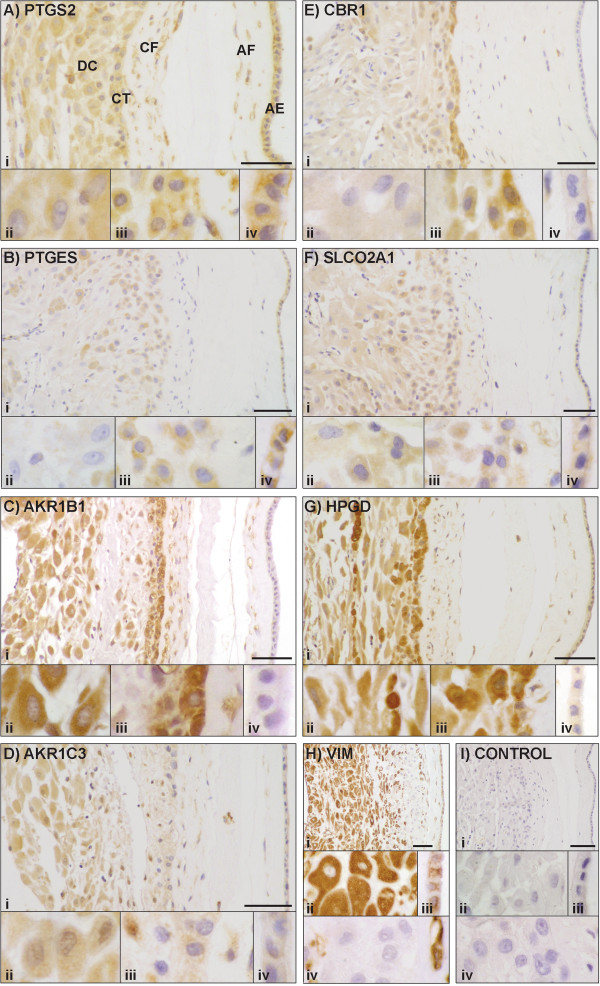
Immunohistochemical localisation of PG pathway proteins in the gestational membranes. (A-I(i)) Lower magnification images show full thickness of membranes, containing amnion epithelium (AE), amnion fibroblasts (AF), chorionic fibroblasts (CF), chorionic trophoblast (CT) and decidual cells (DC). Higher magnification images show (ii) DC, (iii) CT, CF, (iv) AE. (I) Negative control without addition of primary antibody. Scale bar = 50 μm.